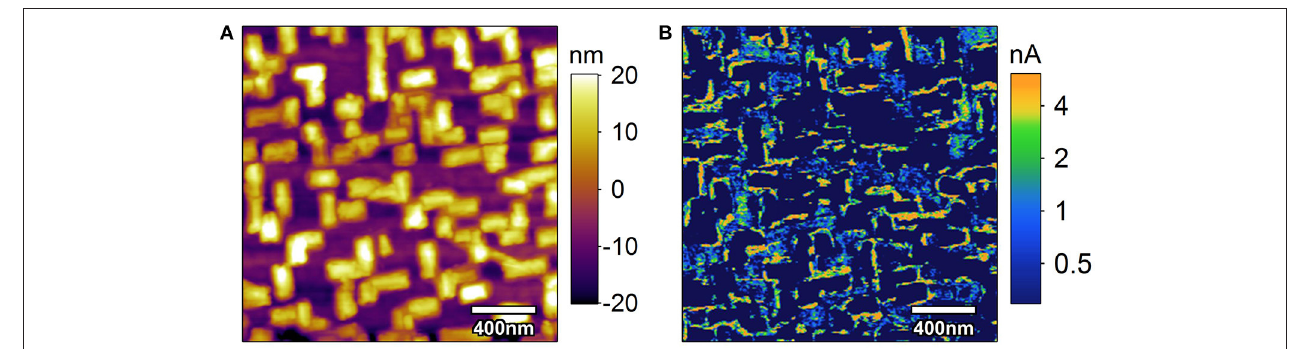
FIGURE 11 | Topography (A) and conductive (B) atomic force microscopy measurements at the surface of a LaMnO 3 :Mn 3 O 4 nanocomposite. (B) Image was taken by applying a voltage of 0.5V.